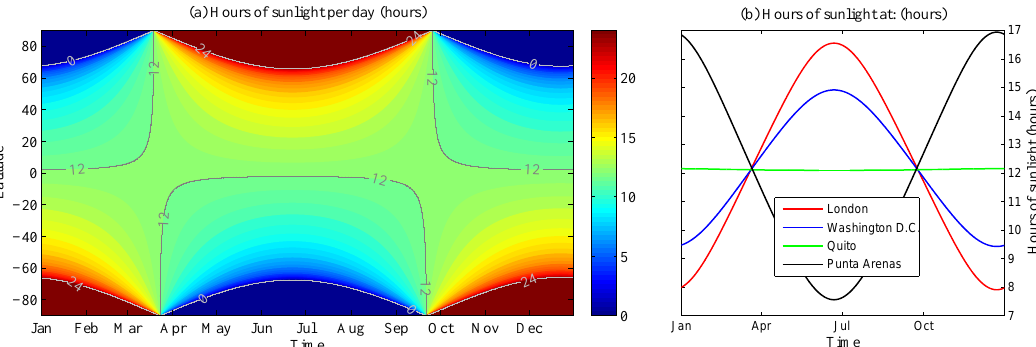
Figure 1. ( a ) Contour plot showing the number of hours of sunlight per day for all latitudes throughout the year; ( b ) hours of sunlight throughout the year for four